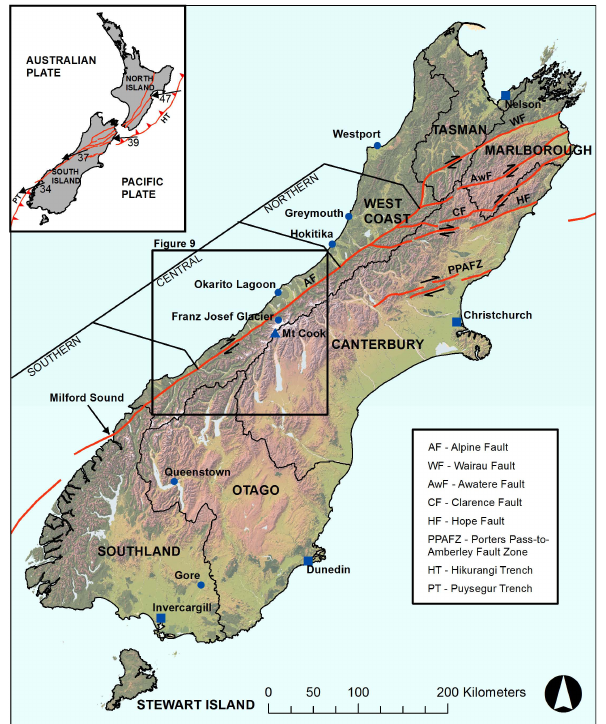
Fig. 1. Overview map of the South Island, New Zealand, showing the major fault systems. Inset: tectonic setting of New Zealand; ar- rows show plate vectors with velocities in mma − 1 .